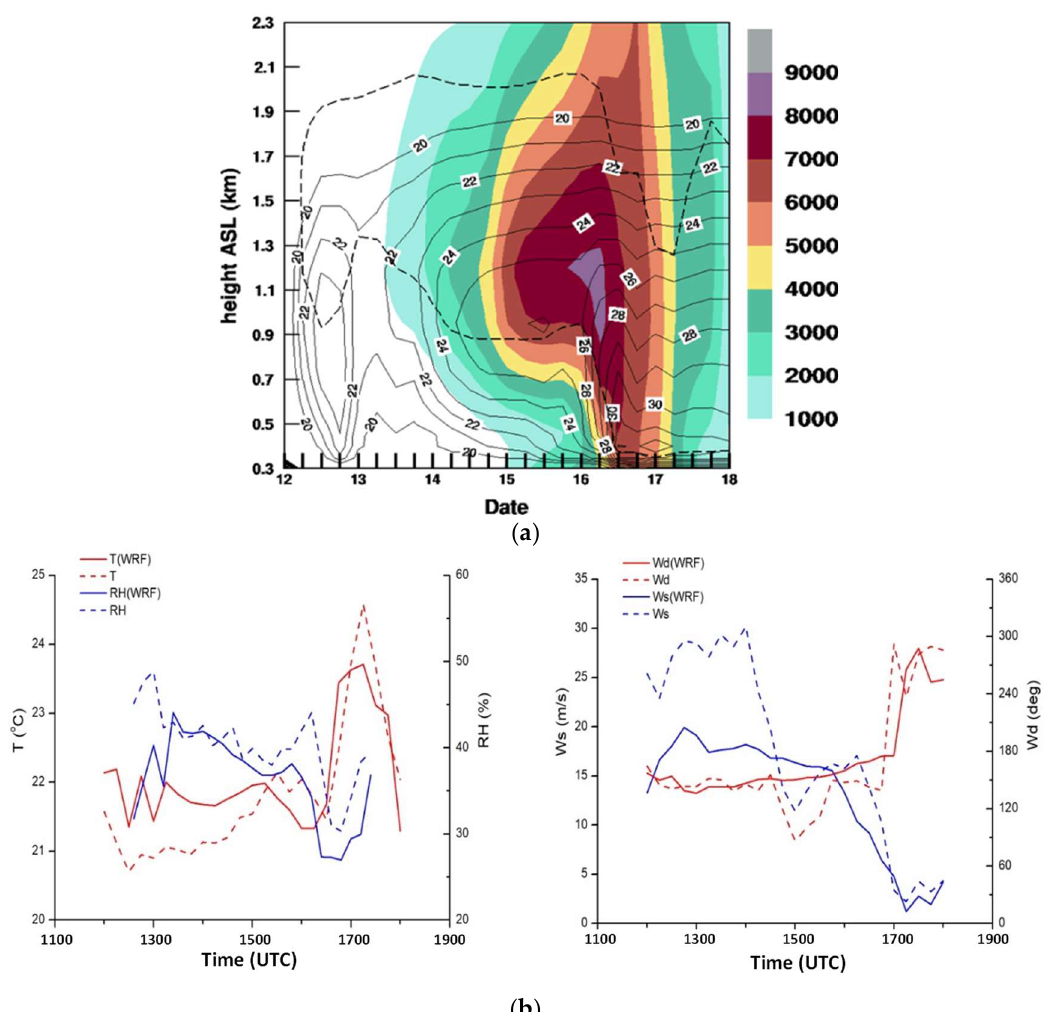
Figure 10. ( a ) Time-height cross section over Finokalia every 15 min from the 1 × 1 km domain, during 1200–1800 UTC, 22 March 2018. The color scale represents dust concentration (μg m −3 ), black line contours is the ambient temperature (°C) and the dashed line represents 10% relative humidity. ( b ) Measured and modeled temperature (°C), wind speed (m s −1 ), wind direction (degrees) and relative humidity (%) at the station of Finokalia, 1200–1800 UTC, 22 March 2018.